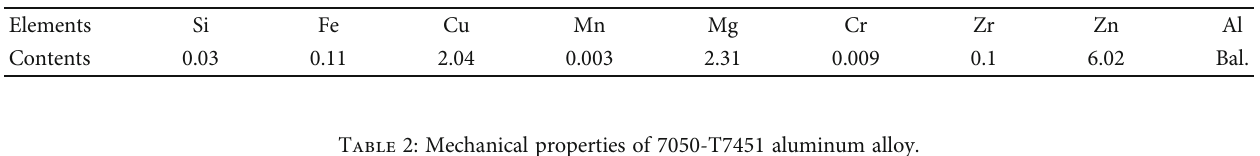
Table 1: Chemical composition of 7050-T7451 aluminum alloy.